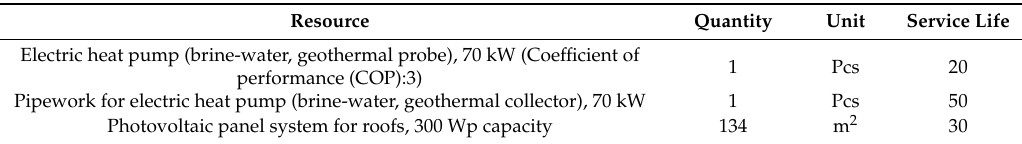
Table 2. Installations